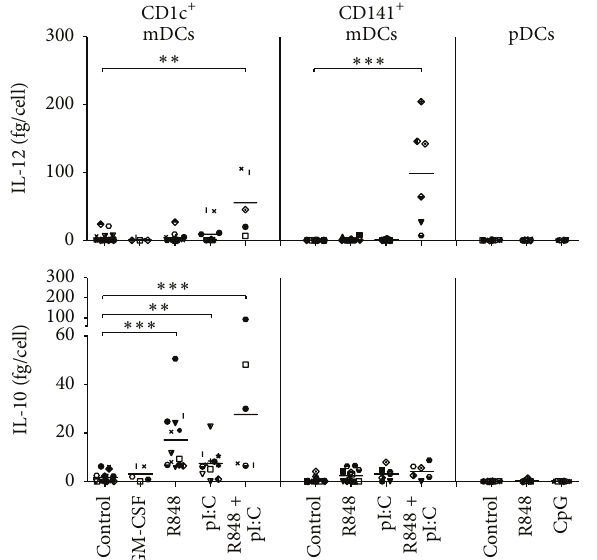
Figure 2: TLR ligation induces differential cytokine production by human blood DCs. The DCs were stimulated as indicated and cultured overnight at 37 ∘ C. IL-10 and IL-12p70 production was analyzedinsupernatantsofovernightculturesbystandardsandwich ELISA ( 𝑛 ≥ 6 ). Each symbol represents one donor (also across the subsets). Significance was determined by Kruskal-Wallis test followed by Dunn’s testing comparing different conditions of the same subset ( ∗∗ 𝑃 < .01 ; ∗∗∗ 𝑃 < .001 ).